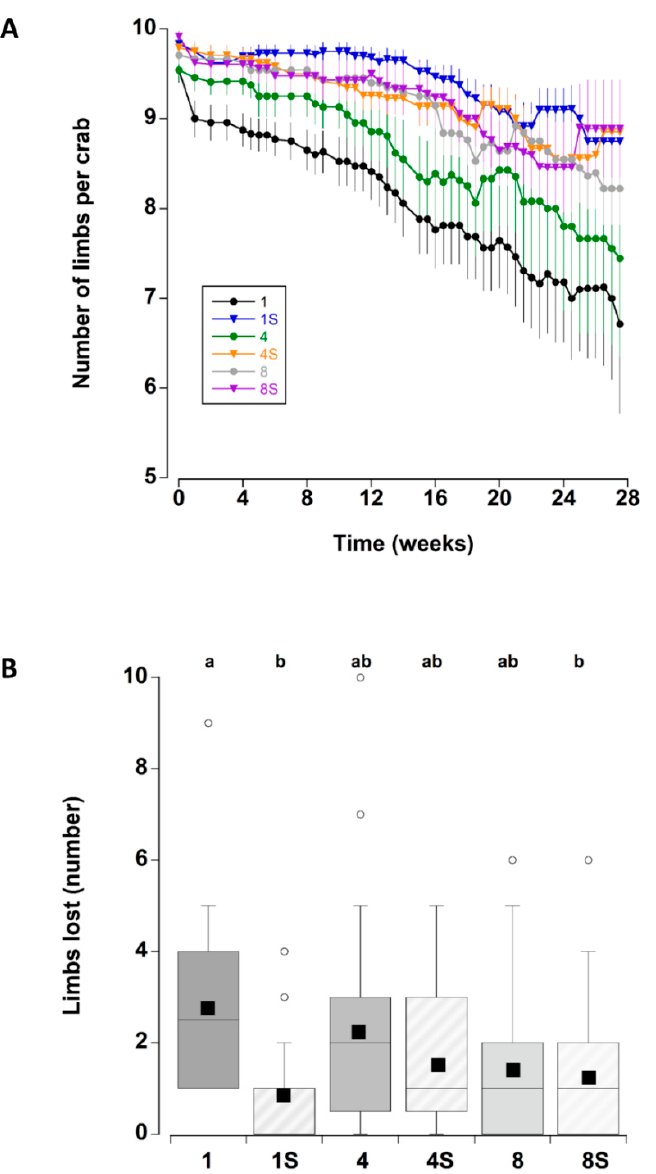
Figure 2. ( A ) Number of limbs per adult male C. maenas (mean ± SE) maintained in the laboratory in densities of 1, 4 or 8 crabs, with (S) or without shelter ( n = 24 crabs per treatment). As the crabs lost limbs the number remaining per crab decreased; in some cases there is an apparent rise associated with the death of a crab and this animal being removed from subsequent calculations of mean numbers ( B ) Total number of limbs lost by individual C. maenas in the six different treatments during the six month experimental period. If a crab died during the experiment the number of limbs lost prior to death was recorded. The box plots represent the 75% confidence intervals, whiskers indicate the 95% confidence limits of the data, the horizontal line is the median number and the square is the mean number of limbs lost. Different letters above each box represent significant differences ( p < 0.05).